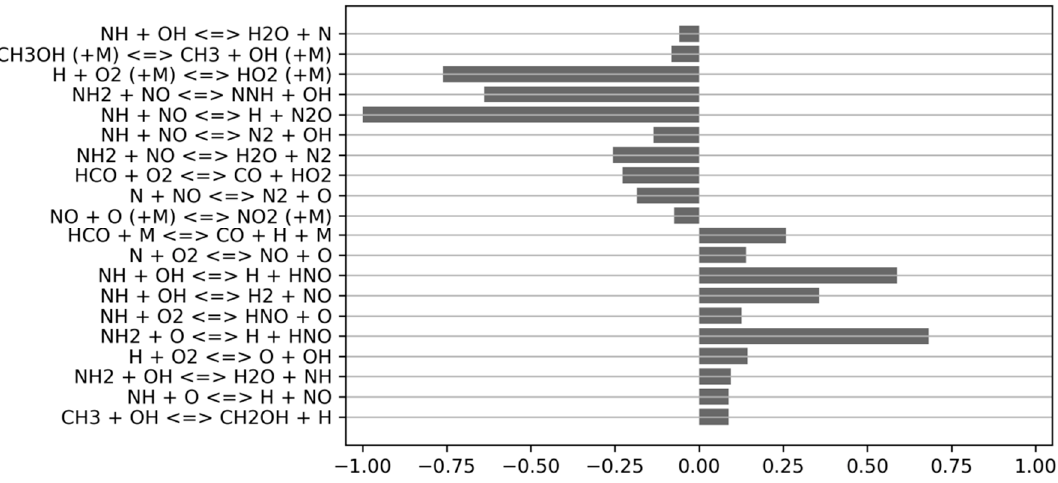
Figure 13. Normalized NO sensitivity diagram for reactor R 0 (5%NH 3 , Φ = 0.71, T = 1556 K, MR = 0.4).